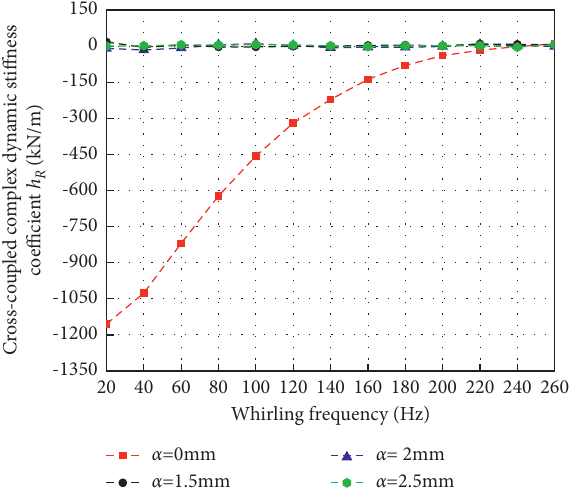
Figure 13: Cross-coupled complex dynamic stiffness coefficient vs. whirling